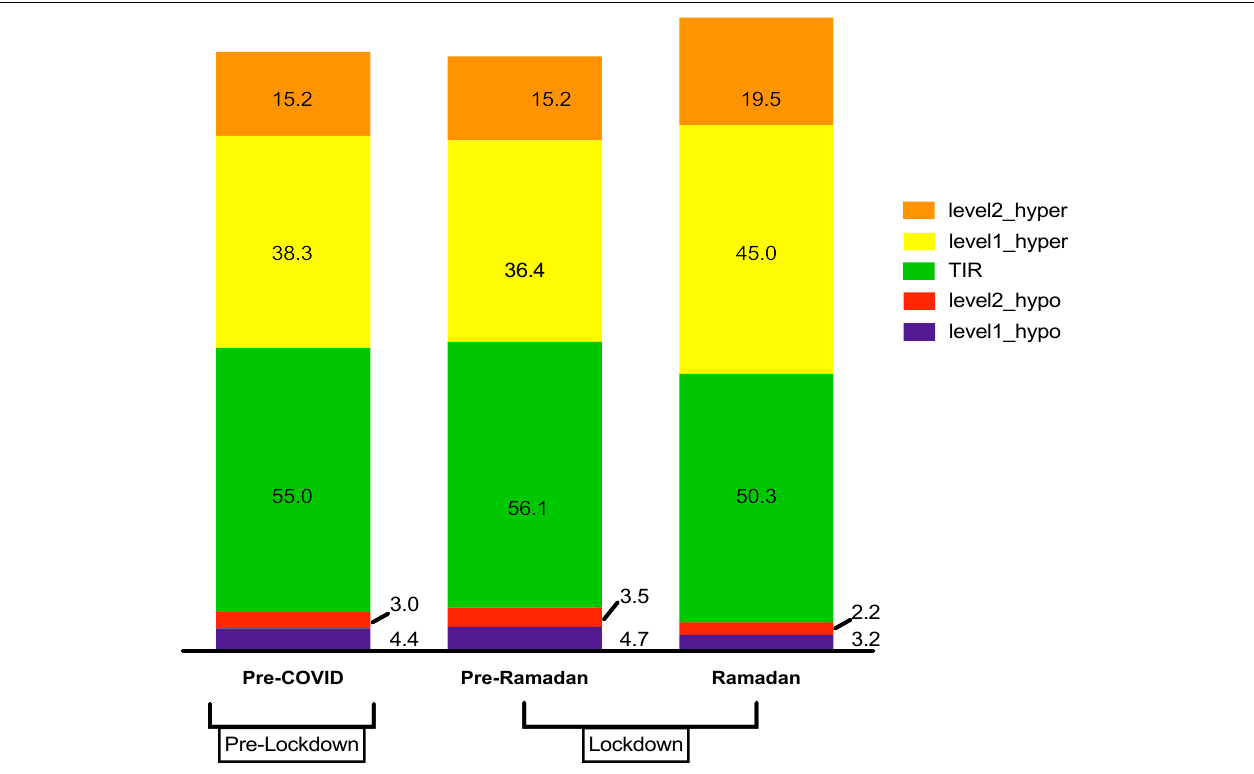
FIGURE 4 | Comparison of percentage of TIRs according to COVID-19 lockdown time points: before lockdown 4/2/2020–14/3/2020 (pre-COVID), during lockdown and pre-Ramadan 20/3/2020–18/4/2020 (pre-Ramadan), and during lockdown and Ramadan 24/4/2020–23/5/2020 (Ramadan). TIR = percentage of TIR (70–180 mg/dL, 3.9–10.0 mmol/L), Level1_hypo = percentage of TBR level 1 ( < 70–54 mg/dL, < 3.9–3.0 mmol/L), Level2_hypo = percentage of TBR level 2 ( < 54 mg/dL, < 3.0 mmol/L), Level1_hyper = percentage of TAR level 1 ( > 180–250 mg/dL, > 10.0 mmol/L), Level2_hyper = percentage of TAR level 2 ( > 250 mg/dL, > 13.9